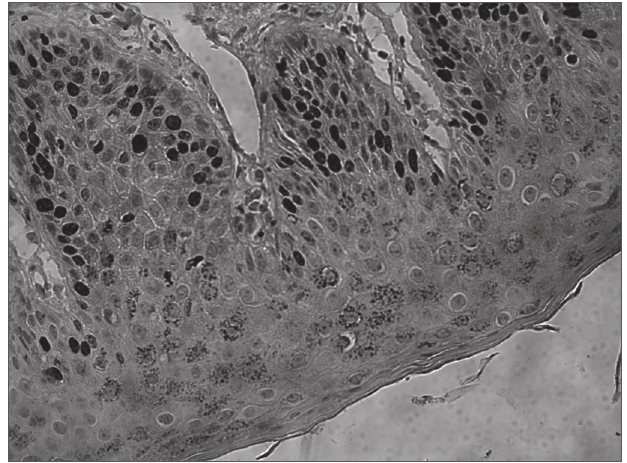
Figura 2. Expressão de Ki-67 na camada basal, estendendo-se para as camadas suprabasais no epitélio do meato acústico externo normal (fonte: Departamento de Morfologia da Faculdade de Ciências